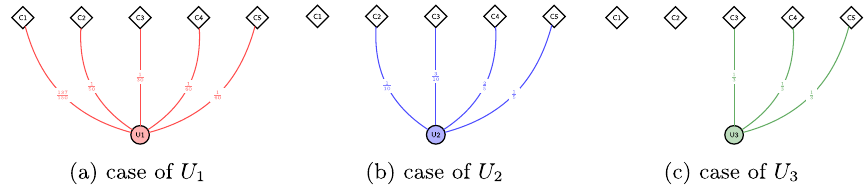
Fig. 2 Example of a bipartite graph projection issued from Fig. 1 with the transition probabilities for different